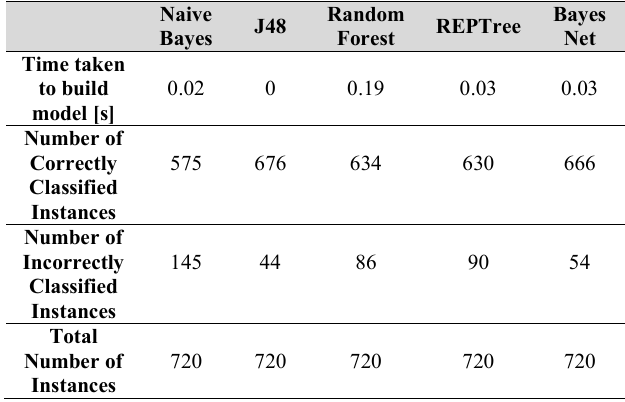
Table 2. Time taken to build model and accuracy of classification